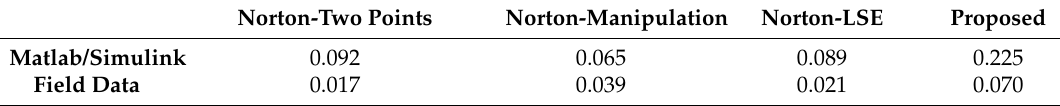
Table 9. Computation time consumed by the four